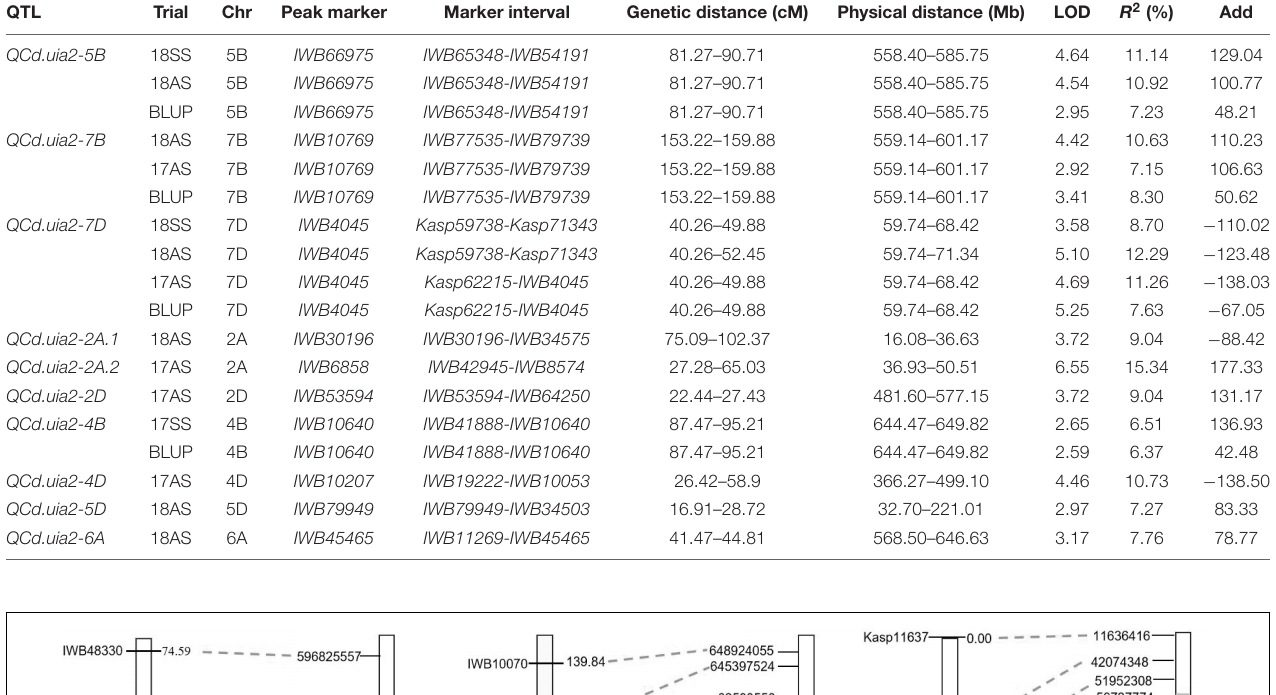
TABLE 4 | Major quantitative trait loci (QTL) for Cd content (mg kg − 1 ) in grain detected in the DH population.